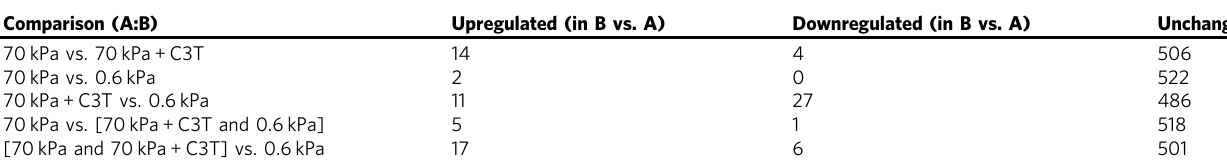
Table 1 Summary of miRNA sequencing data Comparison (A:B) Upregulated (in B vs. A)